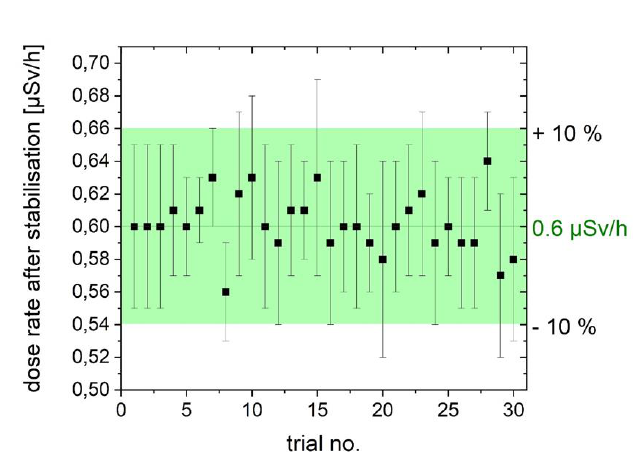
Fig. 9. 137 Cs with 0.5 µSv/h above the background level which is 0.6 µSv/h brought in front of the D3S after step change. The results obtained during 30 individual trials, i.e. the dose rate values after stabilization, are